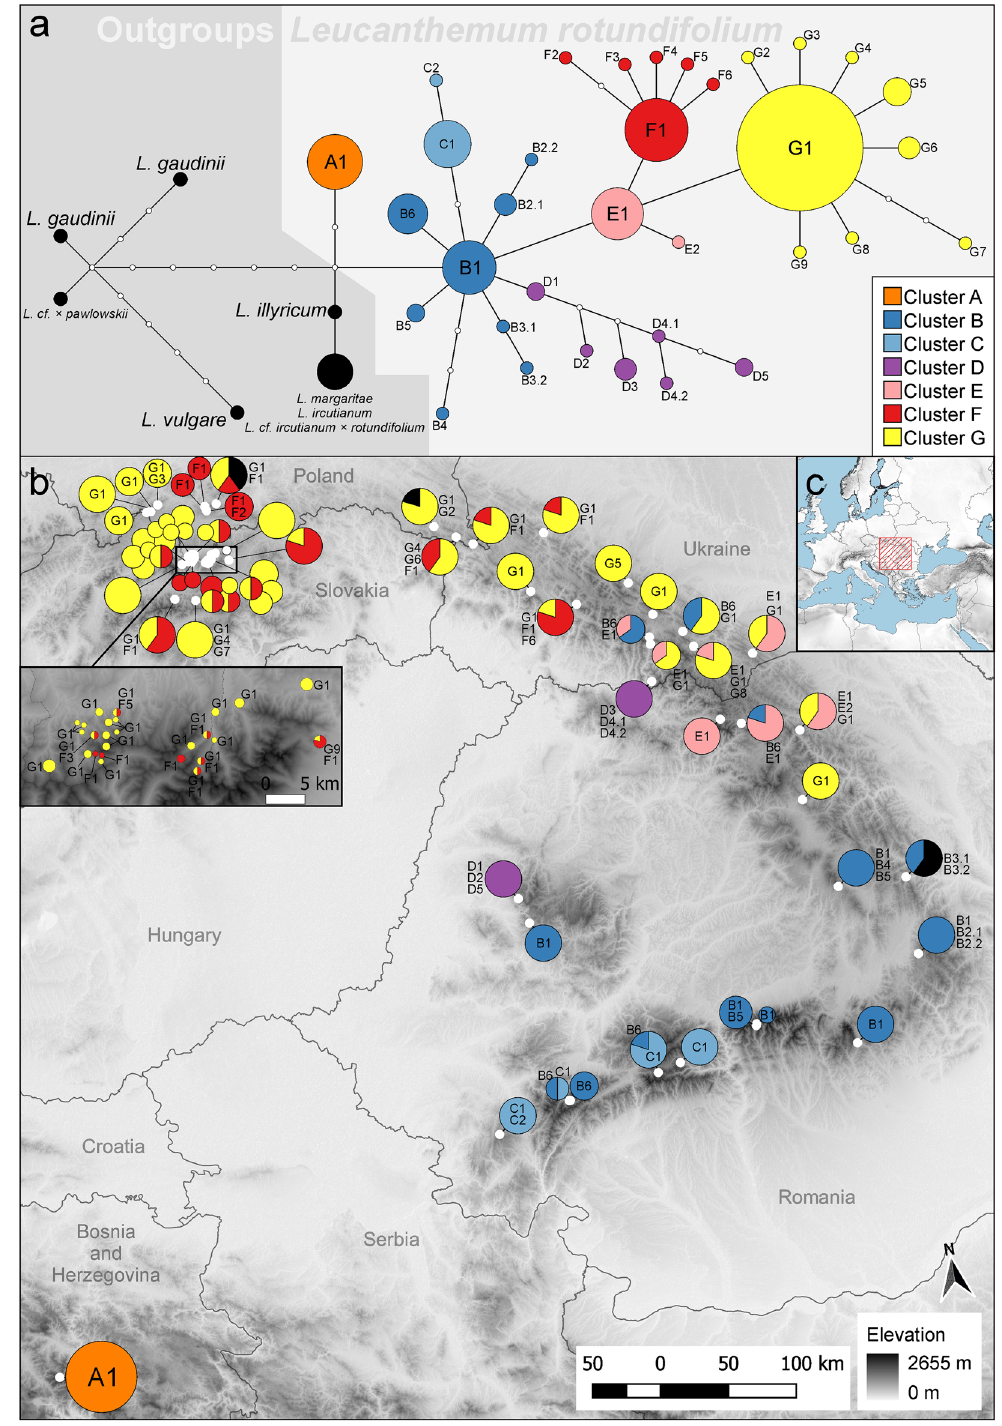
Figure 4. Haplotype network and haplotype distribution. ( a ) Haplotype network constructed with the TCS algorithm using three intergenic spacer regions in cpDNA ( psb A -trn H, ndh C ret-trn V - comp, and trn T(GGU) - comp -psb D - comp). The network contains all representatives of L. rotundifolium included in this study and all sympatric species, but for the sake of clarity, sample names are not shown (for haplotype membership, see Supplementary Material S3). ( b ) Map showing the placement of haplotypes. The size of the pie charts is proportional to the number of sequenced individuals and the size of the slices is proportional to the percentage of individuals belonging to a certain haplotype. Due to dense sampling in the Tatra Mountains, the area is enlarged within an inset on the left. ( c ) Location of the study region. The underlying image ( b , c ) represents the altitude derived from the ALOS DEM dataset 84 . The map is projected in ETRS89 (EPSG: 3035). The maps are drawn using R ver. 3.6.2 76 and QGIS ver. 3.8 77